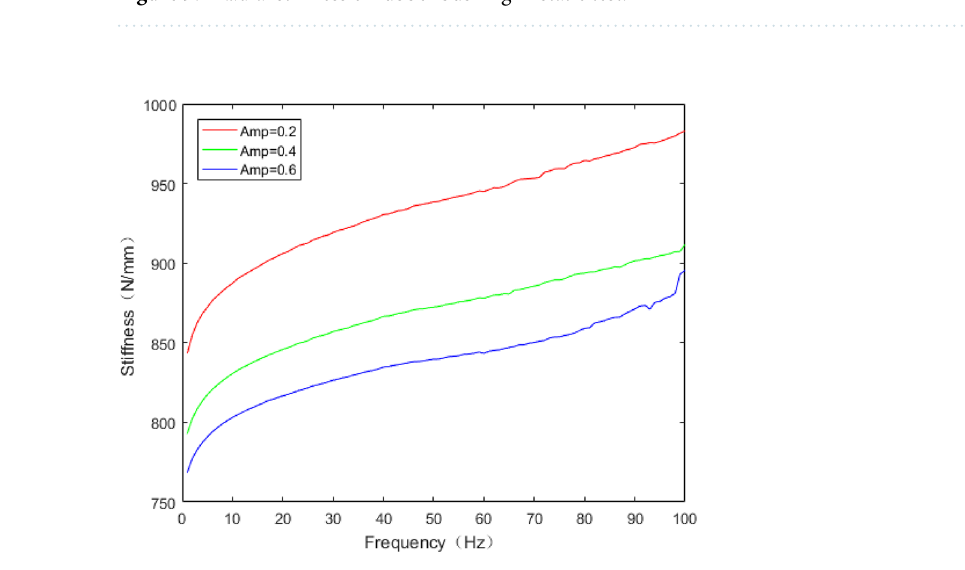
Figure 9. Radial stiffness of rubber bushing in static test.